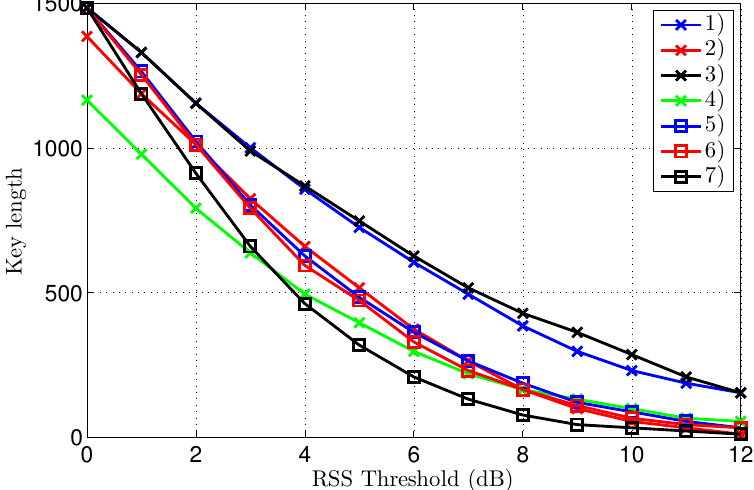
Figure 10. Key Error Rate after reconciliation for different threshold levels, for all